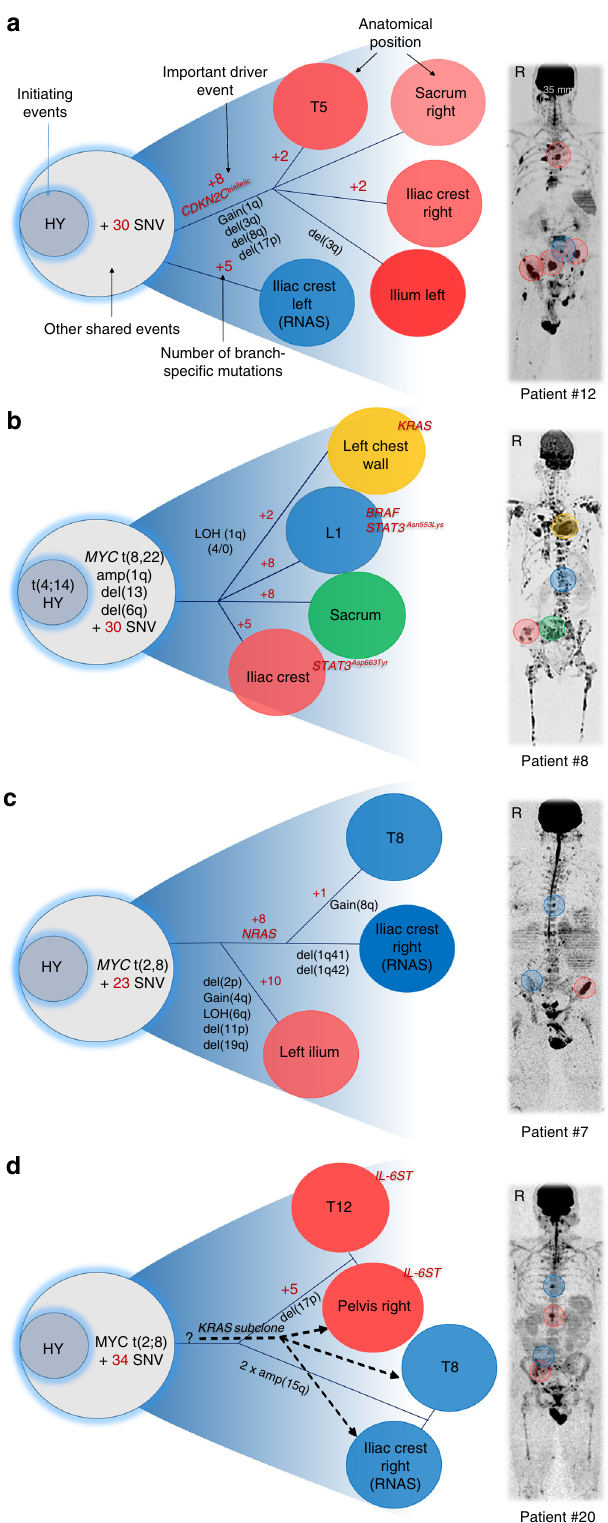
Fig. 4 Multi-regional evolution. Cases with availability of multiple CT-guided samples were selected to analyze the phylogenetic relationship of clones from different regions. The location of samples is marked in the medical images in the right panel using the color code that was assigned to clones ( left panel ). The letter R indicates the right side of the body. a Four focal lesions ( FL ) showed similar genomic pro fi les, sharing the high-risk events bi-allelic deletion of CDKN2C , gain(1q) and del(17p). In contrast, a randomly biopsied non-FL site was low-risk and showed none of these events. b FLs displayed different genomic pro fi les with each of them containing unique driver mutations ( BRAF , KRAS , and STAT3 ). Clones at the iliac crest and L1 contained different STAT3 mutations (STAT3 Asn553Lys vs. STAT3 Asp663Tyr ). c Clones at T8 and the left iliac crest shared a